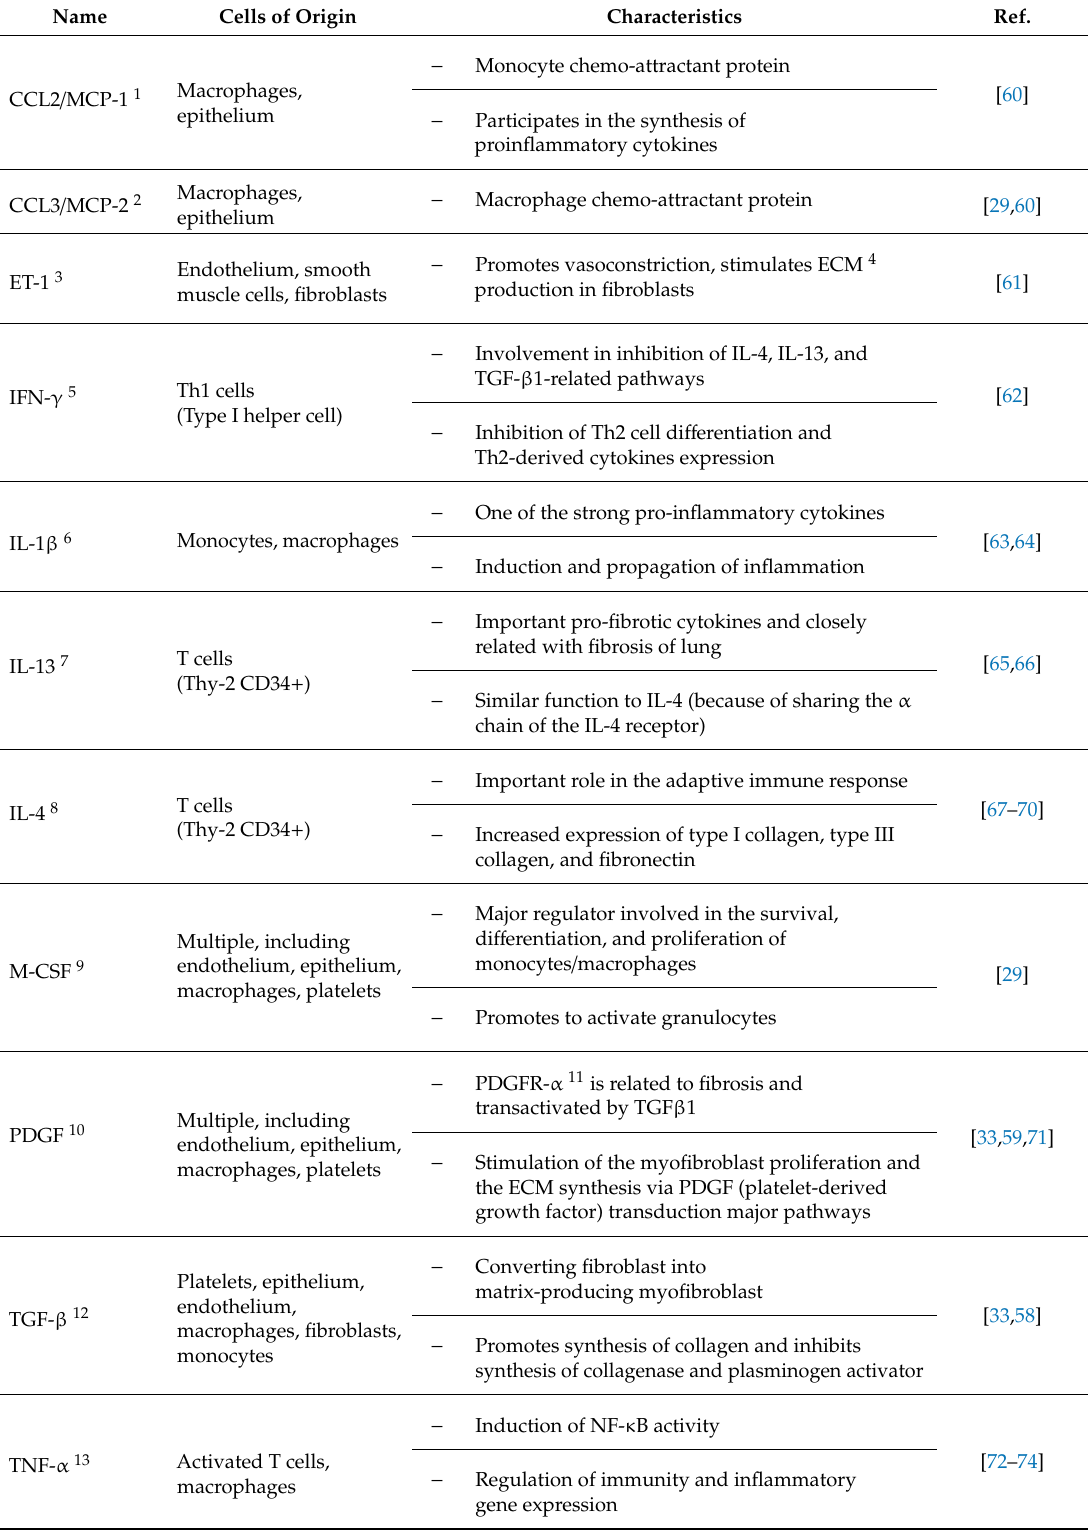
Table 2. Cytokines in the development of